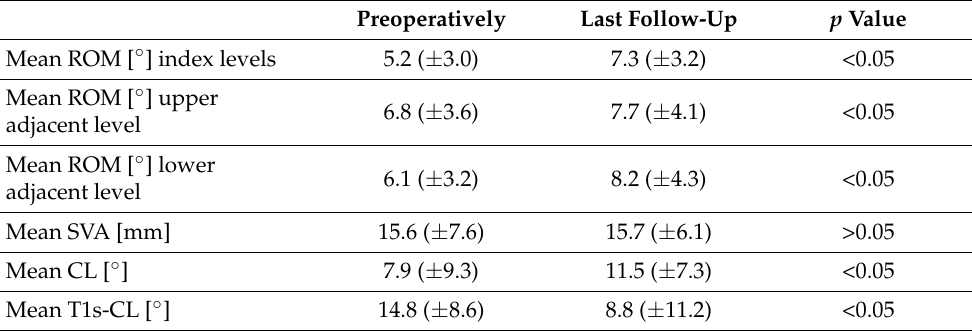
Table 3. Number ( n ) of patients/percentage (%) of the study cohort with mild, moderate, and severe myelopathy as defined by mJOA score preoperatively and at last follow-up. Number of Patients Number of Patients at Last mJOA Score Preoperatively Follow-Up 15–17 (mild myelopathy) n = 25 (44.7%) n = 38 (67.8%) 12–14 (moderate myelopathy) n = 18 (32.1%) n = 13 (23.3%) ≤ 11 (severe myelopathy) n = 13 (23.2%) n = 5 (8.9%) Table 4. Mean ROM of the index and adjacent levels, C2-C7 sagittal vertical axis (SVA), C2-C7 cervical